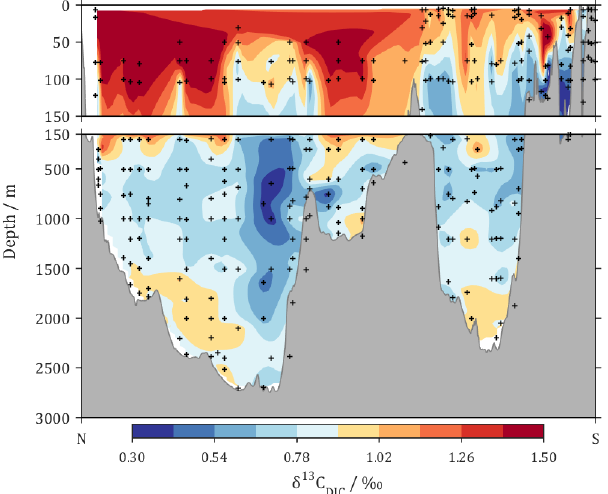
Figure 7. Measured δ 13 C DIC /‰ for all samples from cruise D379. Actual sampling points are indicated by black plusses. Section runs from Iceland to Scotland from left to right; see Fig. 1 for precise route. Bathymetry data are from the GEBCO_2014 grid, version 20141103, http://www.gebco.net, and are approximate to the cruise